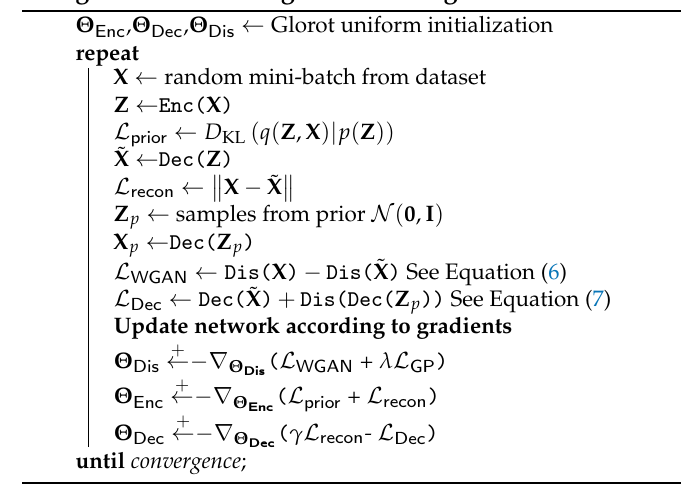
Algorithm 1: Training our Hard Negative